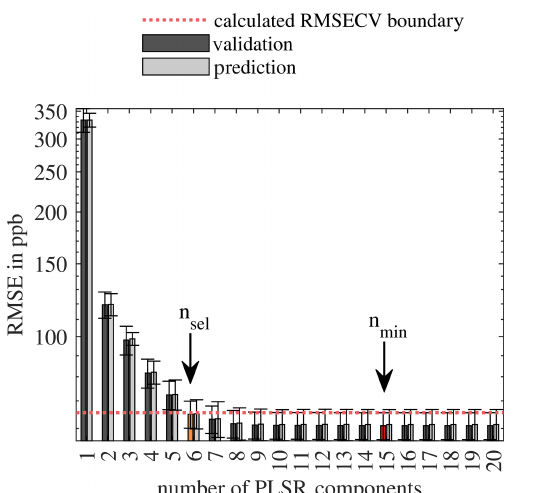
Figure 4. Calculated RMSECV (hyperparameter optimization) and RMSEP (testing) with error bars depending on the number of PLSR components for the AS-MLV-P2 for the carbon monoxide model. The dotted red line indicates the boundary for the calculation of the minimum number of PLSR components, and the orange marked bar shows the RMSECV at the resulting number of components accord- ing to Eq. (2).